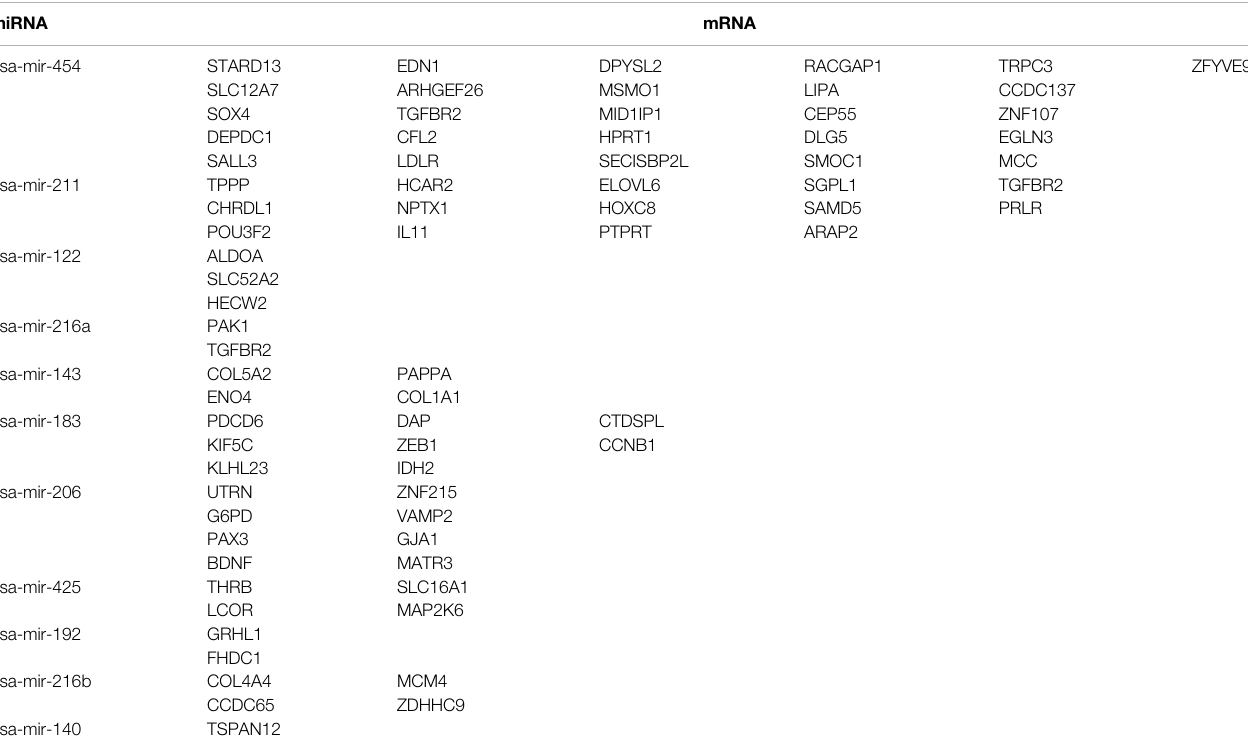
TABLE 3 | Interaction between differentially expressed miRNAs and mRNAs associated with genomic instability. miRNA